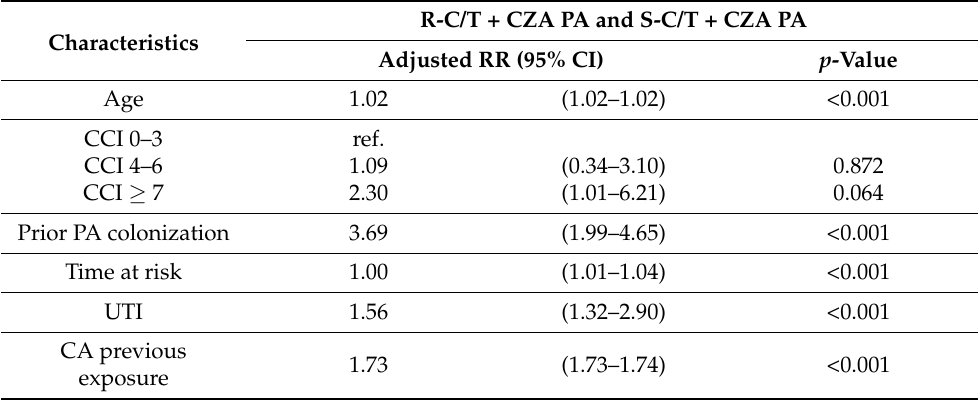
Table 2. Multivariable model of risk factors for the isolation of a R-C/T + CZA PA strain.